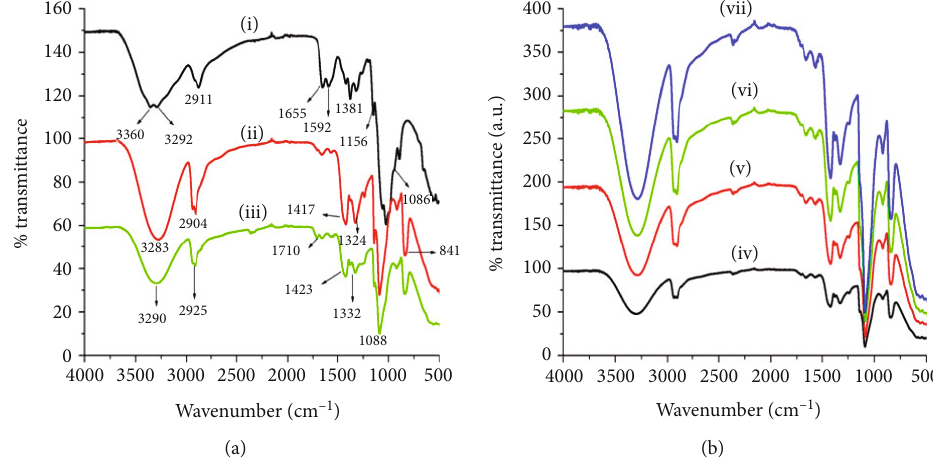
Figure 9: FTIR spectra of the (a) (i) pure chitosan, (ii) pure PVA, (iii) 30/70 CS/PVA blend, and (b) (iv) 0.1wt%, (v) 0.2wt%, (vi) 0.3wt%, and (vii) 0.4wt% Ag/Cu/CS/PVA. Voltage: 20kV; distance: